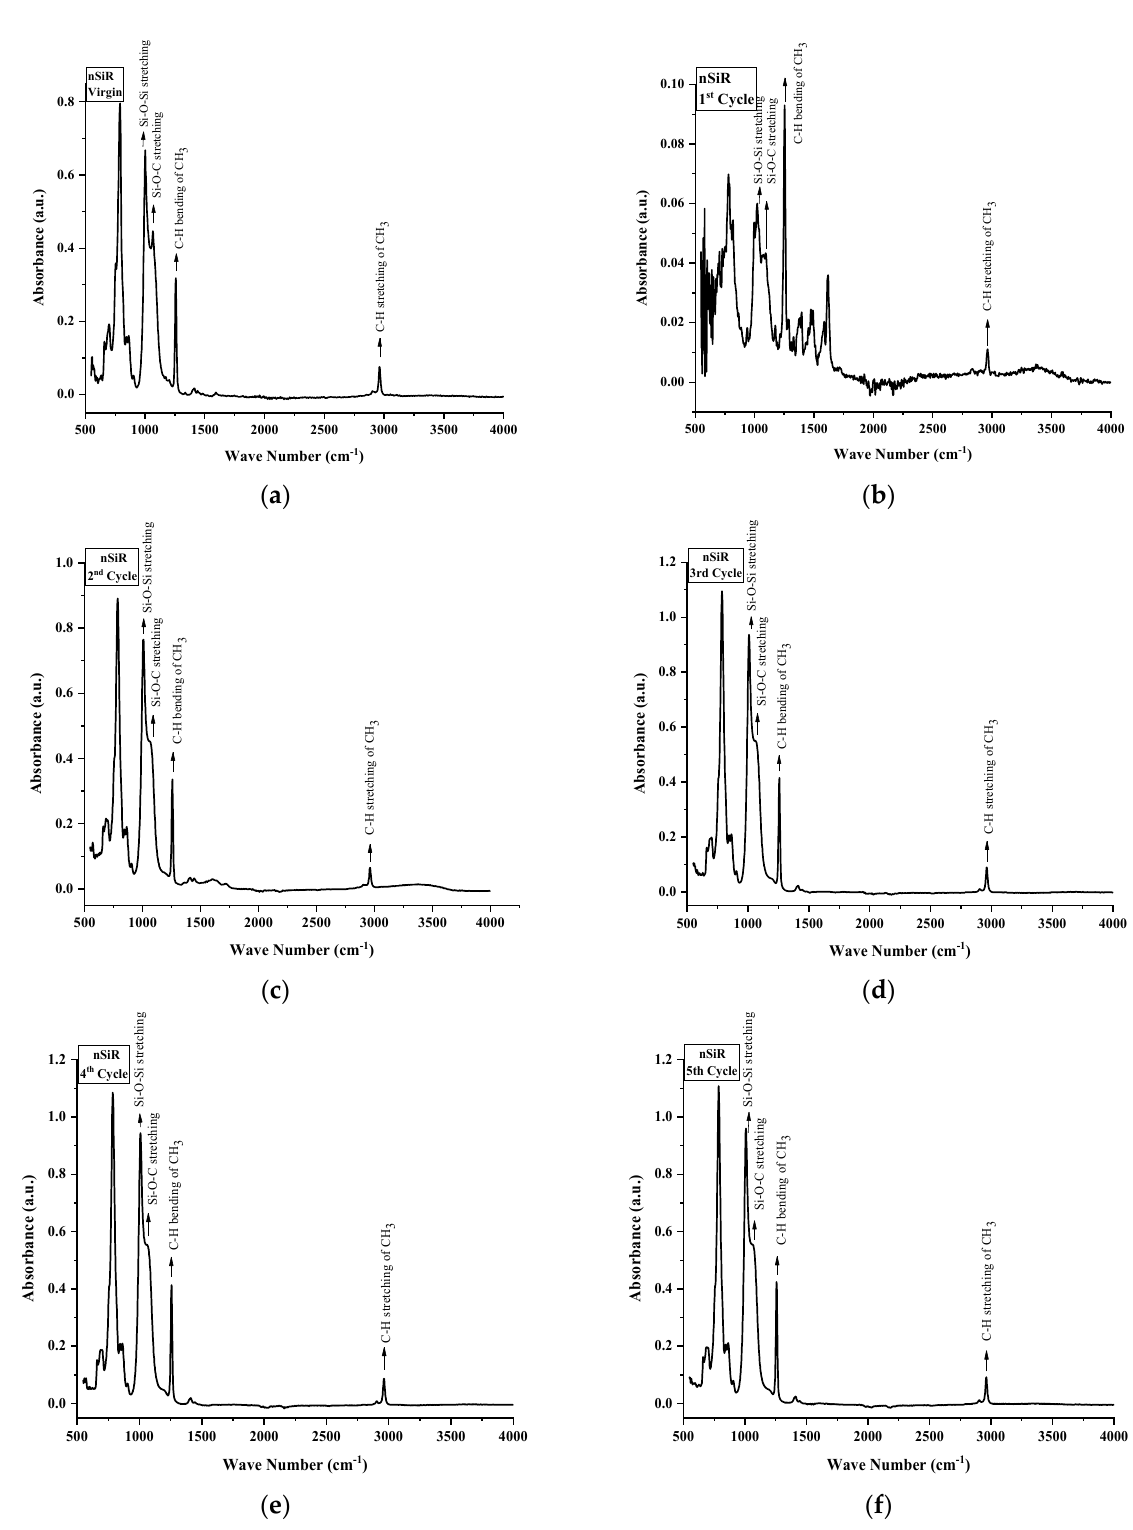
Figure 12. FTIR images of neat silicone rubber: ( a ) virgin; ( b ) after 200 h. ( c ) after 400 h; ( d ) after 600 h; ( e ) after 800 h; ( f ) after 1000 h.